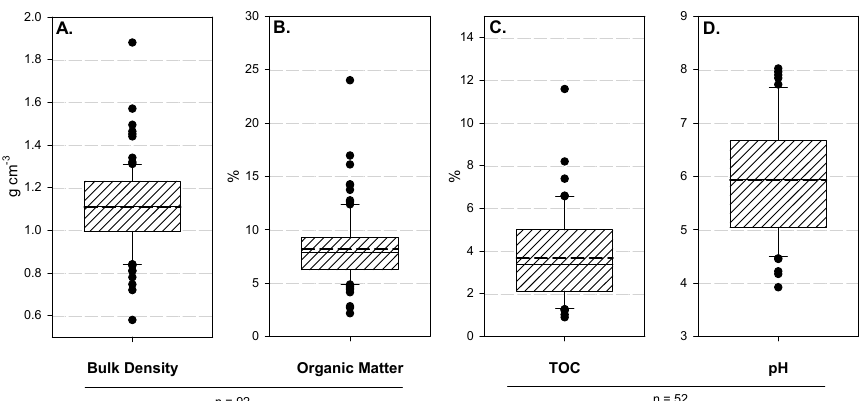
Figure 2. The mean and range of selected properties of urban soils ( A and B from all samples, C and D from a subset of 52 samples). The dashed line is the mean value, the solid line is the median, the box represents the upper and lower quartiles, and the whiskers are the 10th and 90th percentiles. Water-soluble total carbon (WSTC) was not substantially greater in concentration than mean water-soluble organic carbon (WSOC; Figure 3), leaving only a small soluble inorganic fraction.